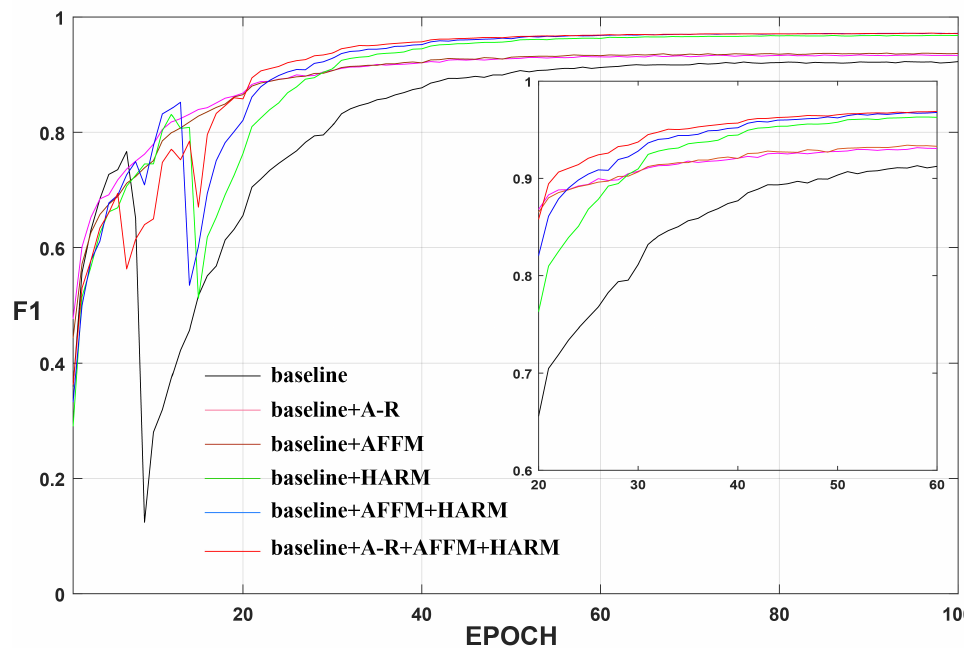
Figure 13. Validation results F1 of ablation experiments on CDD dataset. Smaller rectangular boxes show a clearer result.